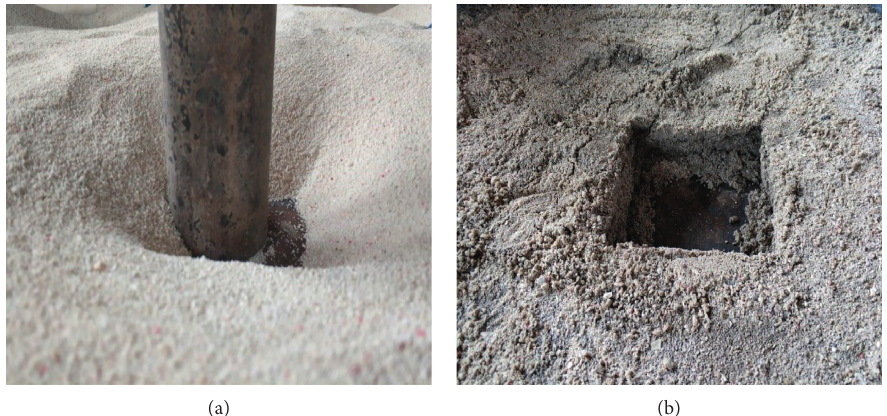
Figure 16: Different failure modes of calcareous sand foundation.